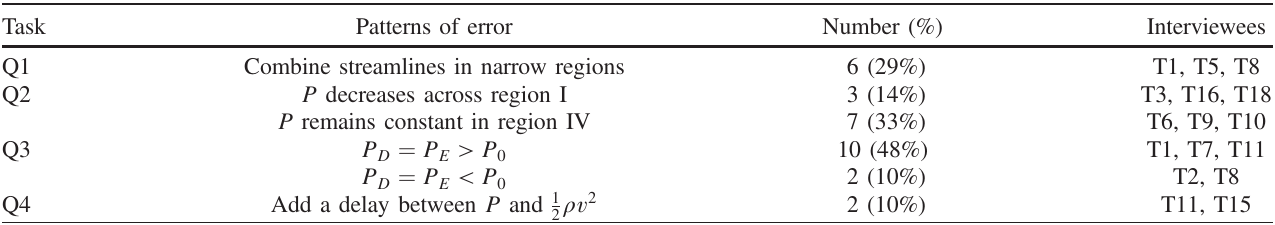
TABLE I. Error patterns, percentages of error, and interviewee identifiers for each sequenced task of the hydrodynamics problem.